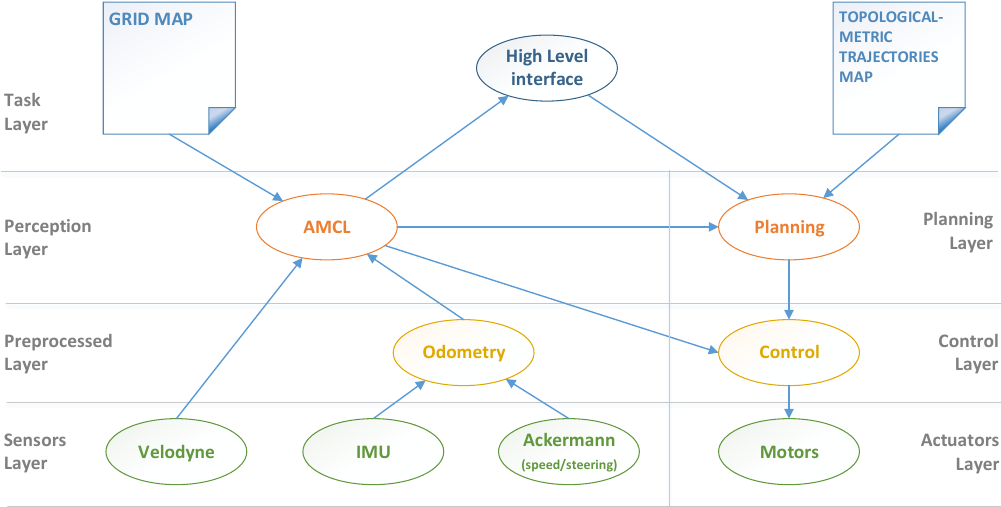
Figure 3. ROS nodes scheme that shows the system architecture in the execution phase for our first framework implementation. Notice that each node is placed at its corresponding abstraction